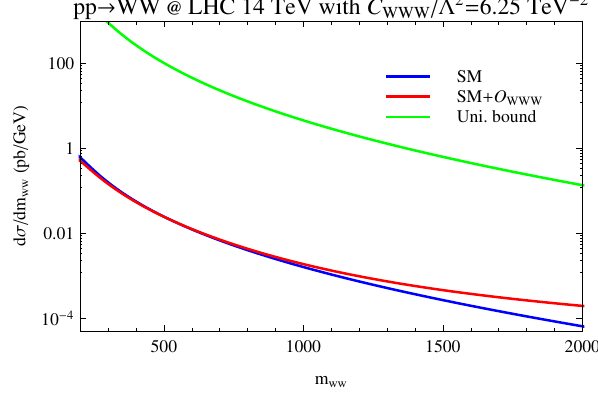
Figure 1. Invariant mass distributions for the production of two W bosons for the SM in blue, for the SM and O WWW in red and for the unitarity bound in green.